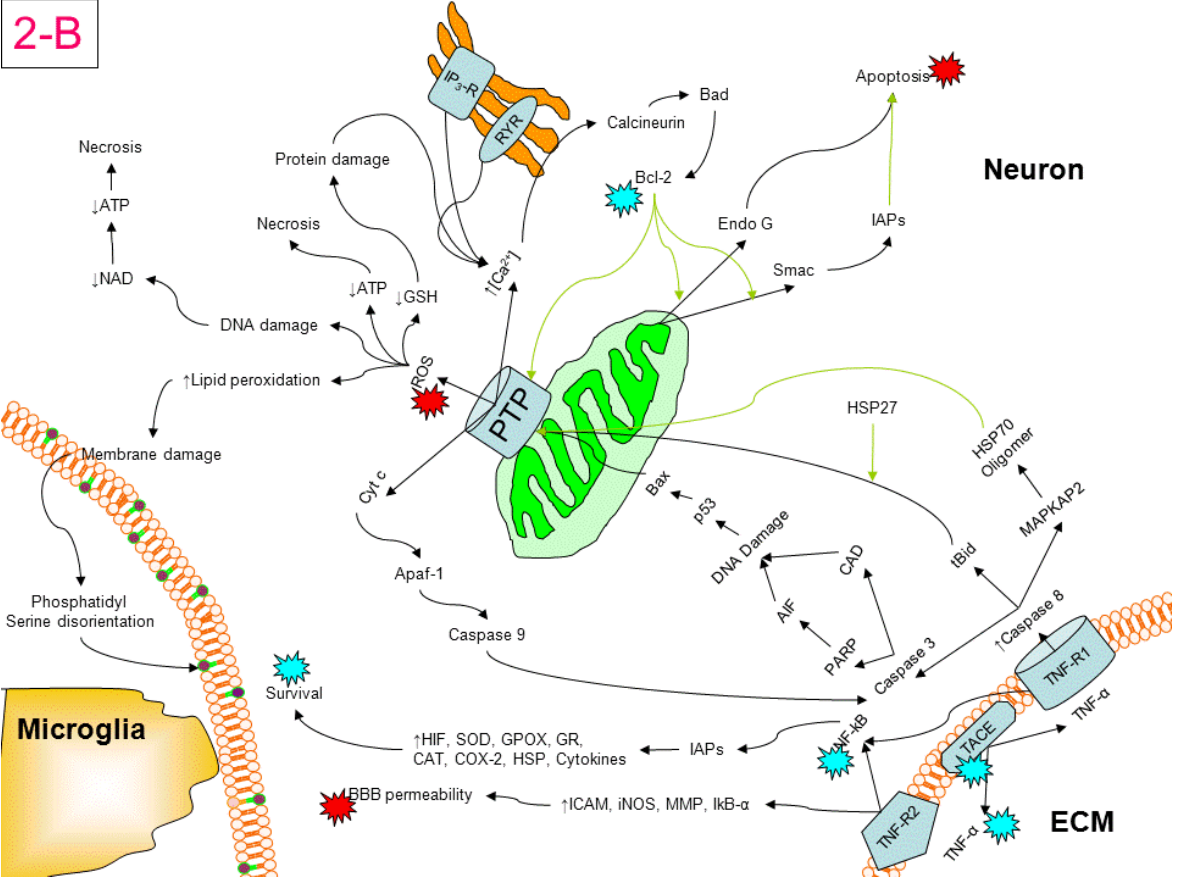
FIGURE 2-B. Injuries caused by ischemia occur in a wide range of subcellular regions of the neuron (plasma membrane, endoplasmic reticulum, and mitochondria; green arrow: neuroprotective, red burst: neurodegenerative). Abbreviations not listed for previous figures: Apaf, antiapoptosis protease activating factor; CAD, caspase-activated DNase; CAT, catalase; Cyt c, cytochrome c; Endo G, endonuclease G; GPOX, glutathione peroxidase; GR, glutathione reductase; GSH, glutathione; IkB-α, inhibitor of NF-κB; iNOS, inducible nitric-oxide synthase; MAPKAP2, phosphorylation of MAPK-activated protein kinase 2; NAD, nicotinamide adenine dinucleotide; PARP, poly (ADP-ribose) polymerase; PTP, permeability transition pore; RYR, ryanodine receptor; TACE, TNF-α converting enzyme; tBid, truncated of Bid; TNF-R1 and R2, TGF-a receptor1 and